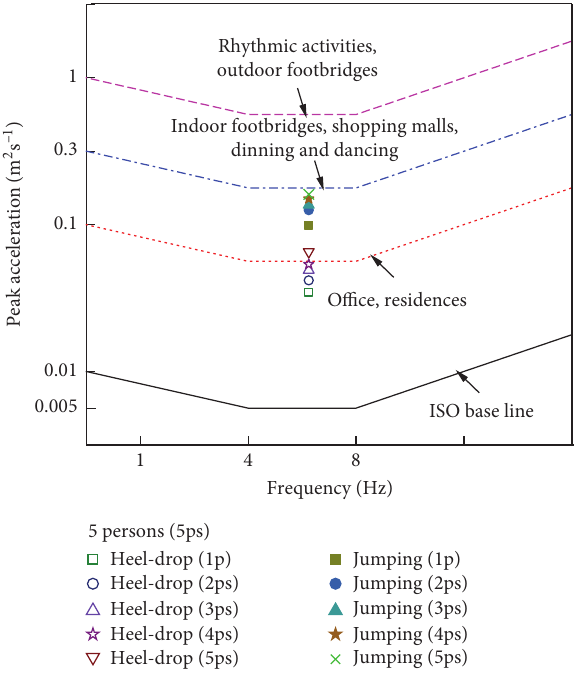
Figure 12: Vibration serviceability assessment by AISC DG-11.